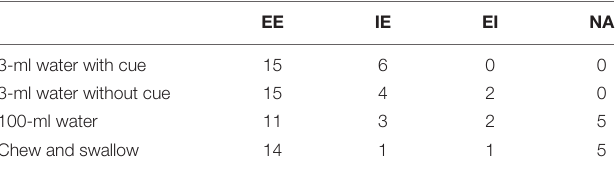
TABLE 2 | Coordination pattern of respiration and